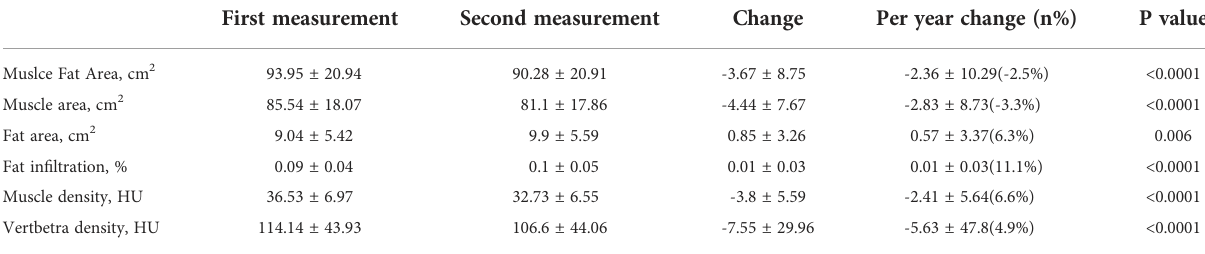
TABLE 2 Per-year Change in muscle and bone indexes in COPD patients.